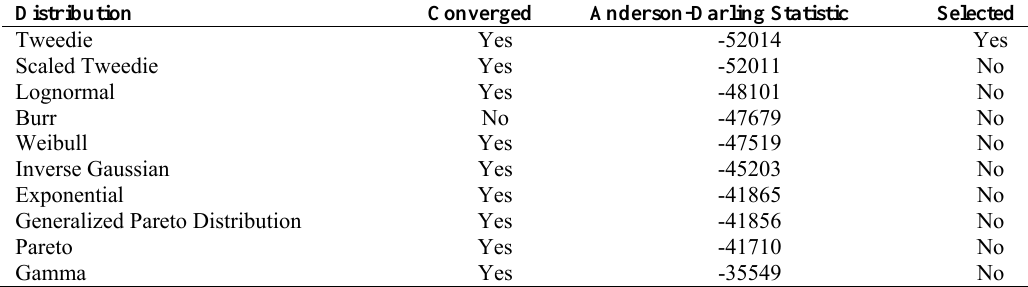
Table 4 : Model Selection based on the Anderson-Darling